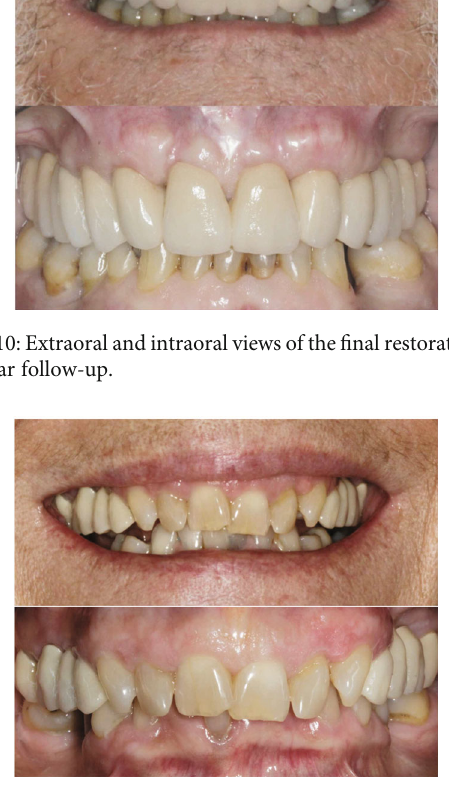
Figure 11: Extraoral and intraoral views showing deep bite and gummy smile.